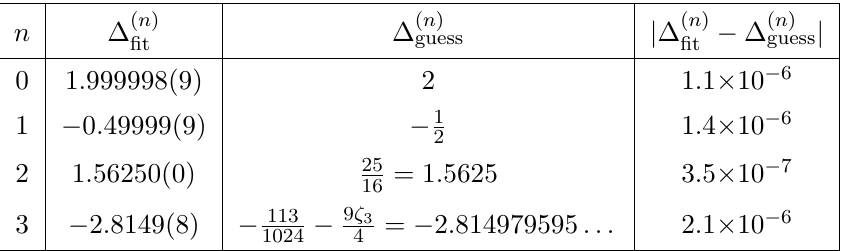
Table 4 . Coe(cid:14)cients of (4.8) for the non-symmetric state with L = 2 ; S = 1, u 4 6 = u (cid:22)4